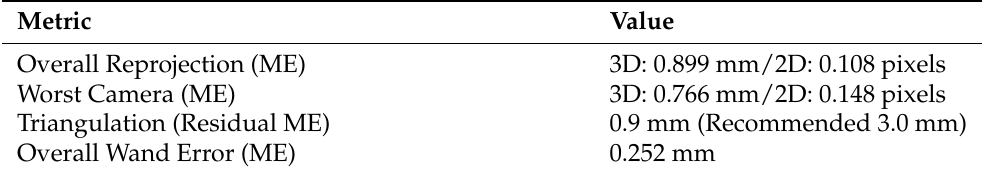
Table 1. Calibration statistics for our MoCap system [41]. For calibration, a wand equipped with markers is used. The exact physical dimension of the wand and marker positions are known to the calibration system. After calibration by moving the wand through the whole trackable volume, the tracking system can calculate the above error metrics based on the exact marker positions and the measured marker positions throughout the calibration procedure. Overall, every metric shows that our MoCap system provides submillimeter